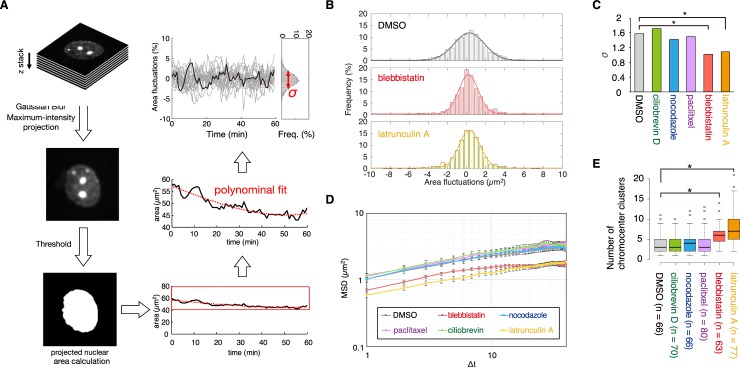
Effect of inhibition of dynamic nuclear deformation on CC clustering.(A) Schematic representation of quantification of projected nuclear-area fluctuation. (B) Normalized histograms of the combined projected nuclear-area fluctuations for all the cells and time points in DKO cells treated with either DMSO (control), blebbistatin or latrunculin A (S12 Fig). The solid curves represent Gaussian fits. (C) Standard deviations of the distributions of the nuclear-area fluctuation in cells treated with various drugs or the DMSO control (S12 Fig). Two-sample F-tests were done to assess significance; * denotes P < 0.01. (D) Ensemble- and time-averaged mean square displacement (MSD) curves between CC clusters and the nuclear center of mass in cells treated with the various drugs or the DMSO control during the 1 hour imaging period (S13A Fig). Error bars represent SEM. (E) Quantification of CC clusters observed during differentiation following drug treatment.